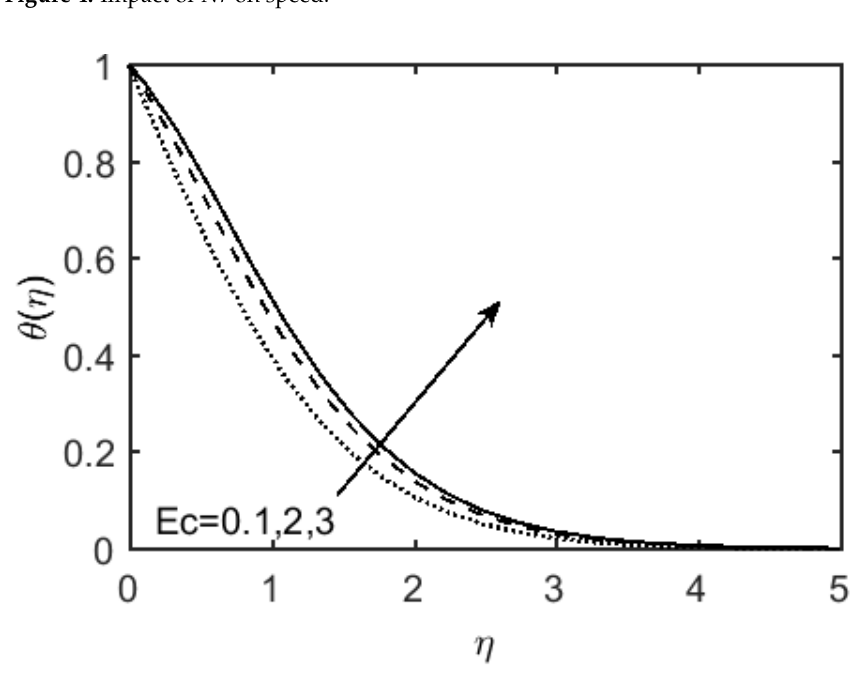
Figure 5. Impact of Ec on hotness.